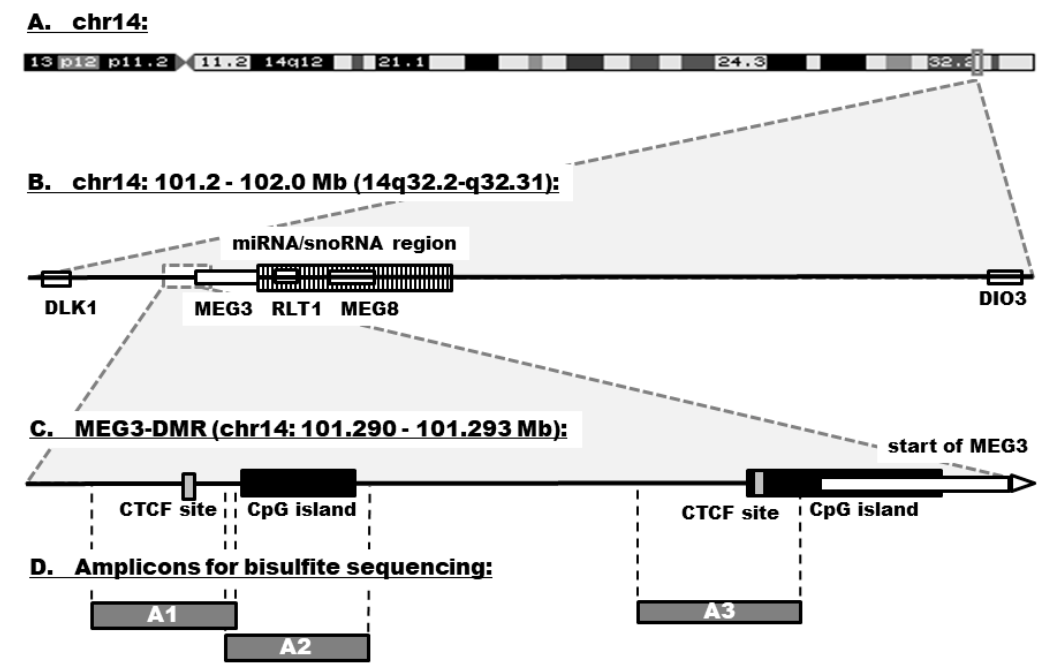
Figure 1. Genomic organization of the DLK1–DIO3 domain. ( A ) The region is located on chromosome 14q32.2. ( B ) It contains three paternally expressed protein-coding genes ( DLK1, RTL1 , and DIO3 ), three maternally expressed noncoding genes ( MEG3, MEG8, and antisense RTL1 ), many snoRNAs, and a large cluster of 54 miRNAs (striped bar). ( C ) The expression within the region is under the control of MEG3 -DMR that overlaps with the promoter and the 5 ′ -end of the MEG3 gene. MEG3 -DMR contains several CTFC binding sites (gray bars) and CpG islands (black bars). ( D ) The schema shows localization of amplicons (A1–A3) in the region that were used for methylation analyses.